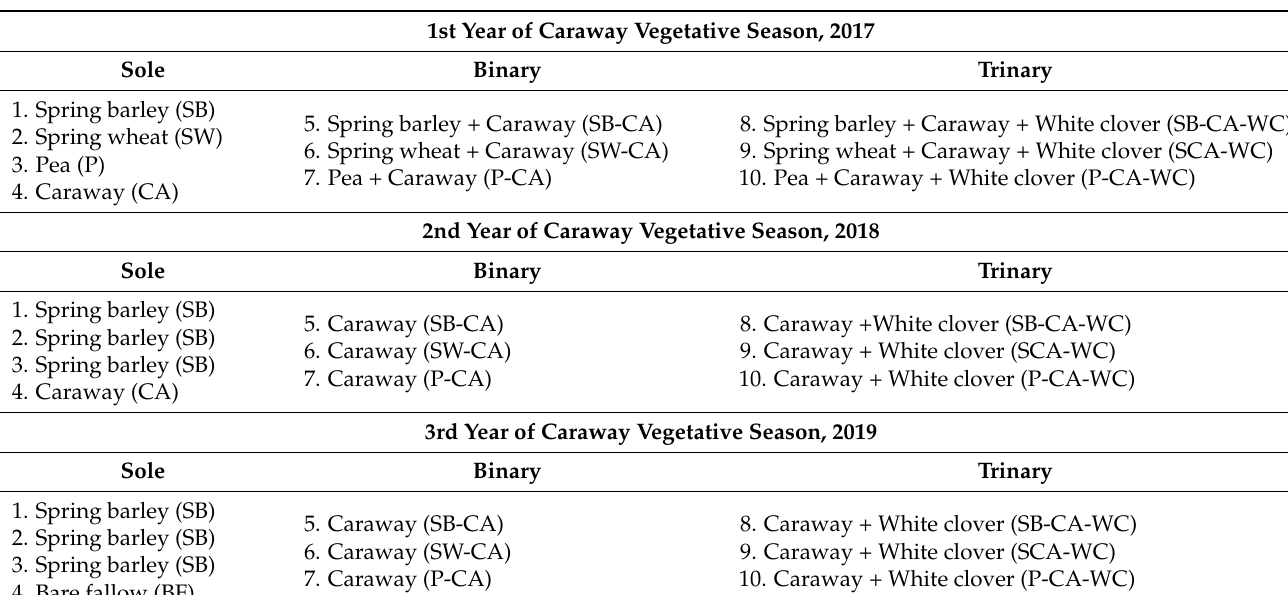
Table 1. The treatments of the experiment with their crops and varieties of sole, binary, and trinary crops.